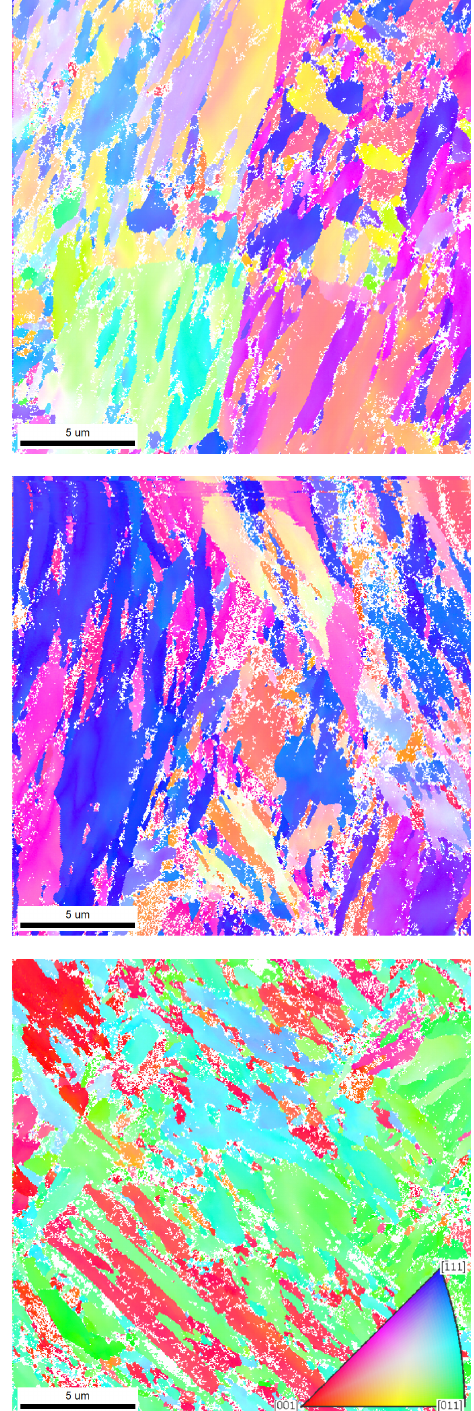
Figure 5. Effect of annealing on the phase composi- tion of the clad where ferrite is red, Cr yellow and austenite blue (upper as cladded, middle after 550 ◦ C annealing for 2 h, bottom after 550 ◦ C annealing for 2+2 h).